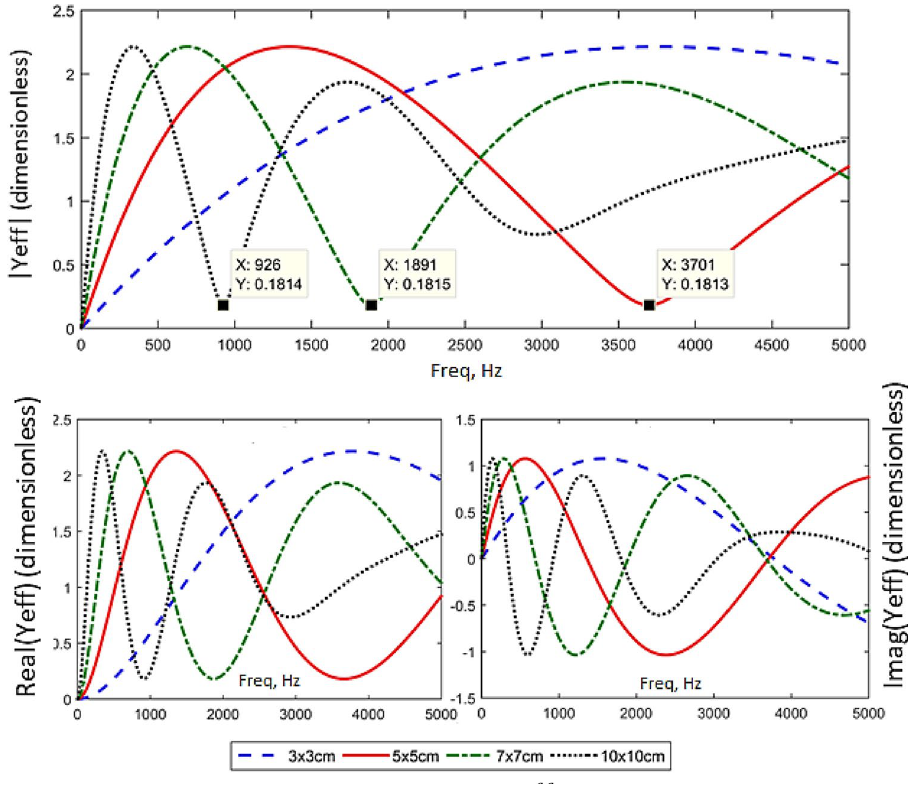
eff ∞ with varying PZT patch dimensions (graph in